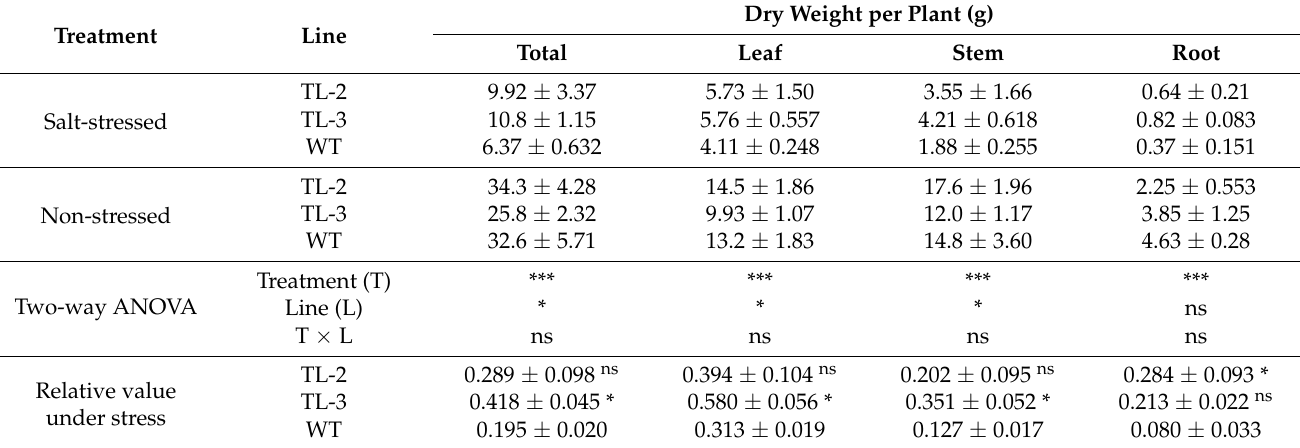
Table 2. Dry weights of transgenic faba bean lines TL-2, TL-3, and wild-type (WT) after 29 days of salt stress followed by a 14-day recovery period. Relative values of dry weights under stress compared to the non-stressed condition are also shown. Values are the means ± SE. Asterisks indicate significant differences within treatment by Dunnett’s test using WT as control upon significant interaction indicated by two-way ANOVA. *** p < 0.001, * p < 0.05, ns insignificance with p >